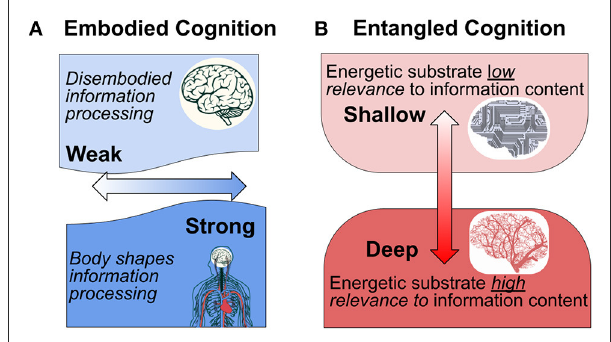
FIGURE1 Interpretation of embodied cognition in the context of the nervous system. (A) Traditional conceptions of embodied cognition results are interpreted along a weak-strong horizontal axis (light to dark blue). According to the traditional interpretation, the “strength” of embodiment reflects the extent to which the body shapes cognition through a unified perceptual-action-cognition system (After Binder and Desai, 2011, who propose an intermediate “embodied abstraction” interpretation. According to their proposal, the impact of embodied semantics on perceptual representations depends on the context). (B) We hypothesize an orthogonal interpretation of “entangled” embodiment that indicates the extent to which the physical-energetic substrate is of relevance to information processing content.